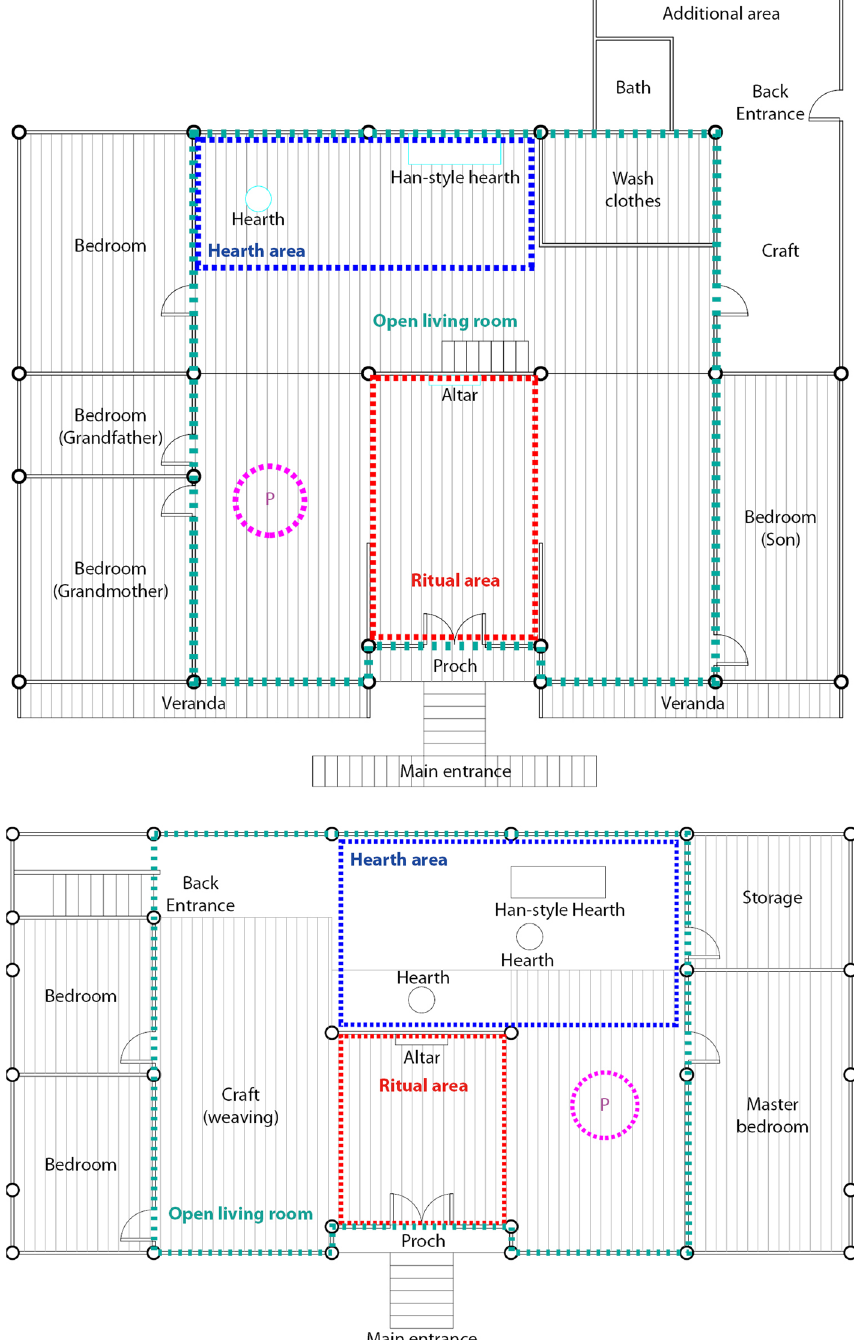
Fig. 9 Floor plans for S7 (upper) and S8 (lower) show the typical type-B layout: two entrances and the open living room being divided into four areas (Source: Yang